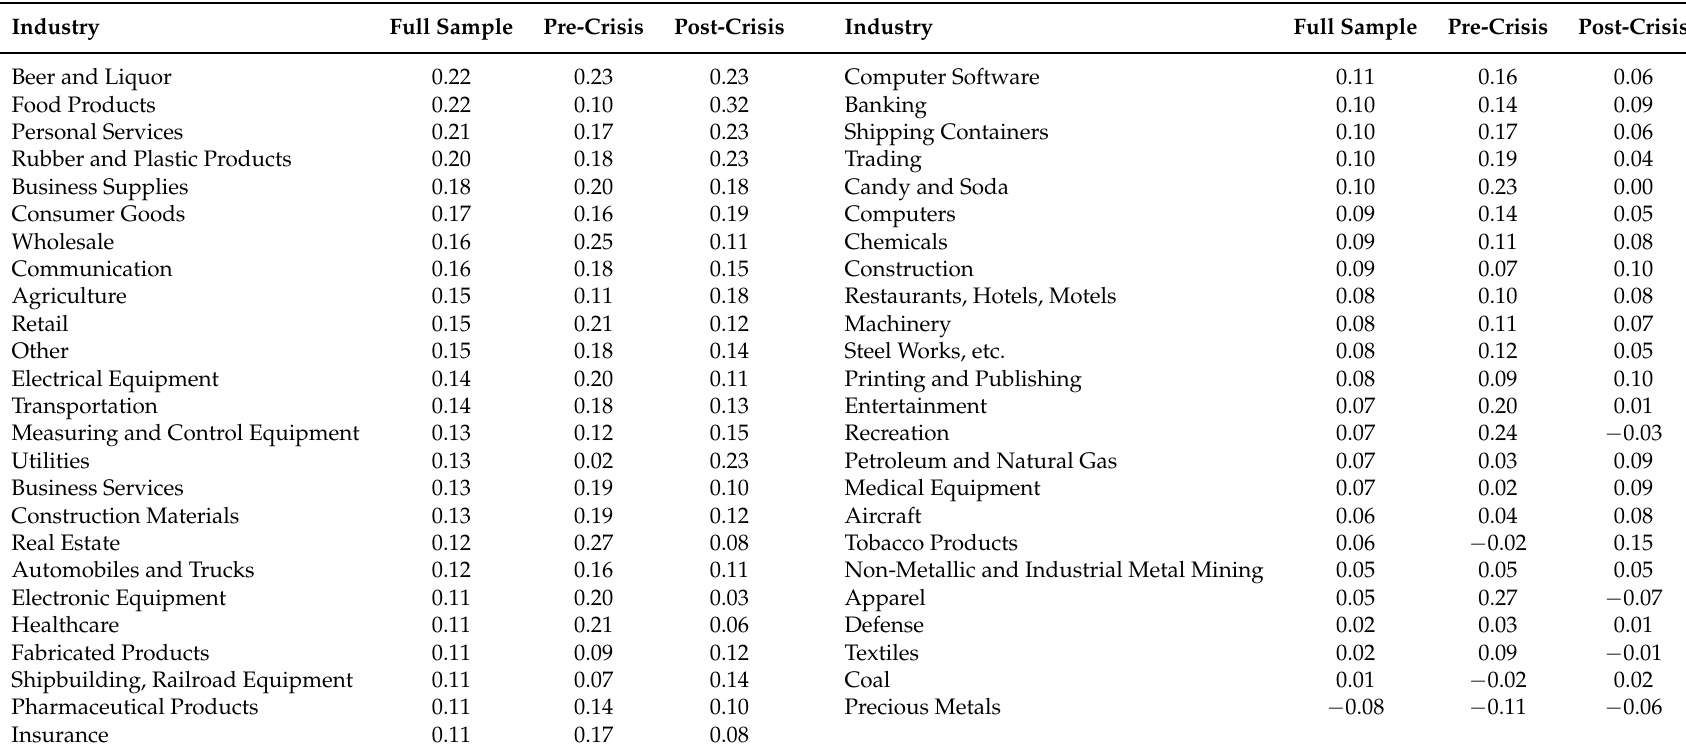
Table A3. The table reports the Pearson correlation between the modern art index and each of the Fama and French 49 industry groups over three time periods. Full sample refers to correlations computed using monthly data ranging from 2002:04 to 2017:09; pre-crisis correlations are computed using data ranging from 2002:04